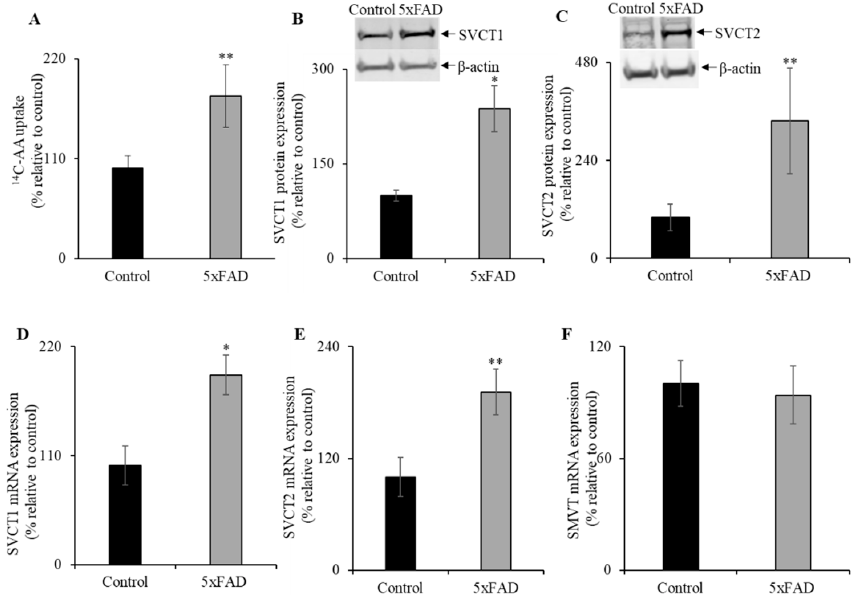
Figure 3. Upregulation of vitamin C transporters functional expression in 5xFAD mice jejunum. (A) Mouse jejunum segments were prepared from 5xFAD and WT littermate mice as described in “Methods”. We performed carrier-mediated 14 C-AA (0.1 µ Ci) uptake in jejunum segments. ( B , C ) Mouse jejunum mucosal protein (60 µ g) was isolated from 5xFAD and WT littermate mice and used for western blot analysis. Jejunum protein was separated on NuPAGE 4–12% mini gel and proteins were transferred onto polyvinylidene difluoride (PVDF) membrane. Blots were incubated with custom-made